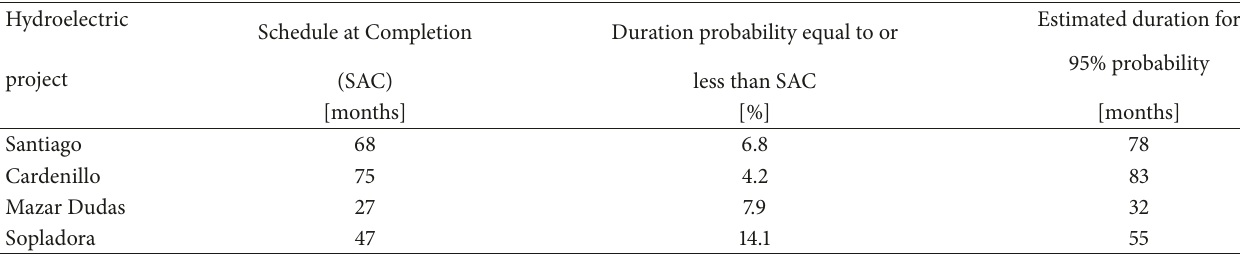
Table 3: Outcome of simulation models for total